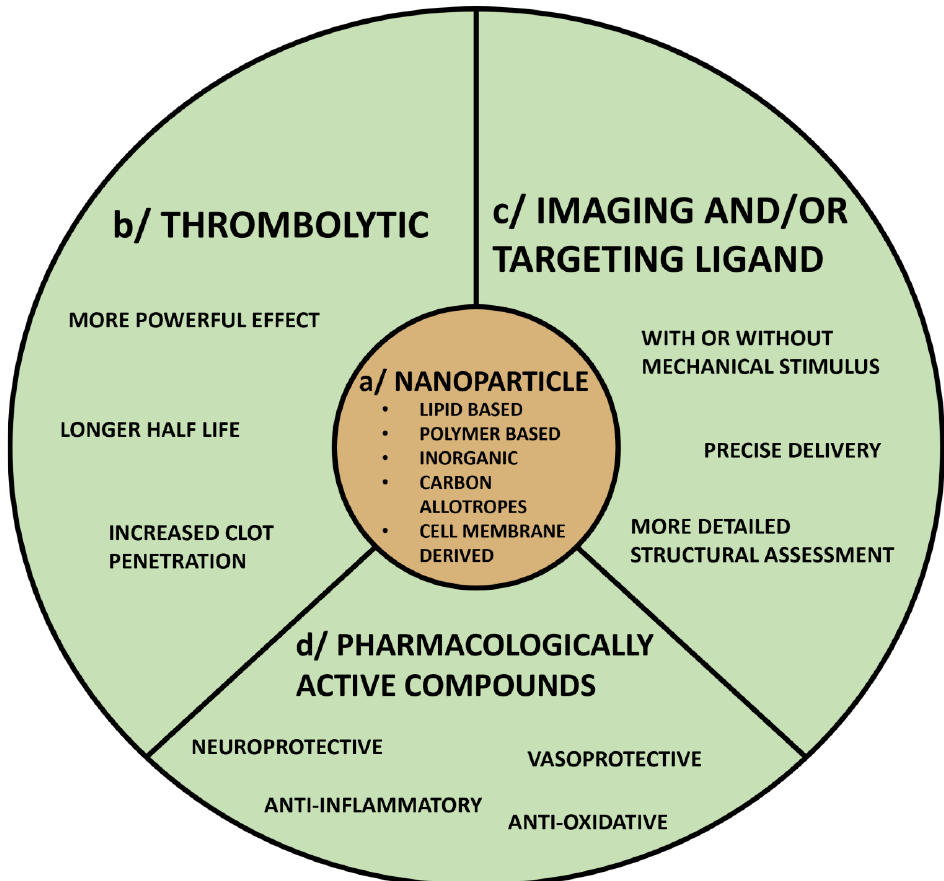
Figure 5. Nanoparticle-based formulations as tools in stroke diagnosis and treatment. Nanoparticle- based formulations have multiple potential applications for clinical management of acute ischemic stroke including delivery of thrombolytics and neuro/vaso-protective agents, improvement of imag- ing capabilities, and more precise targeting, which should enhance the safety profile of acute treat- ments. Key components of such formulations are nanoparticles ( a ), combined with either thrombolyt- ics ( b ) and/or imaging or targeting ligands ( c ), or other components such as pharmacologically active compounds ( d ), which could decrease tissue injury and enhance